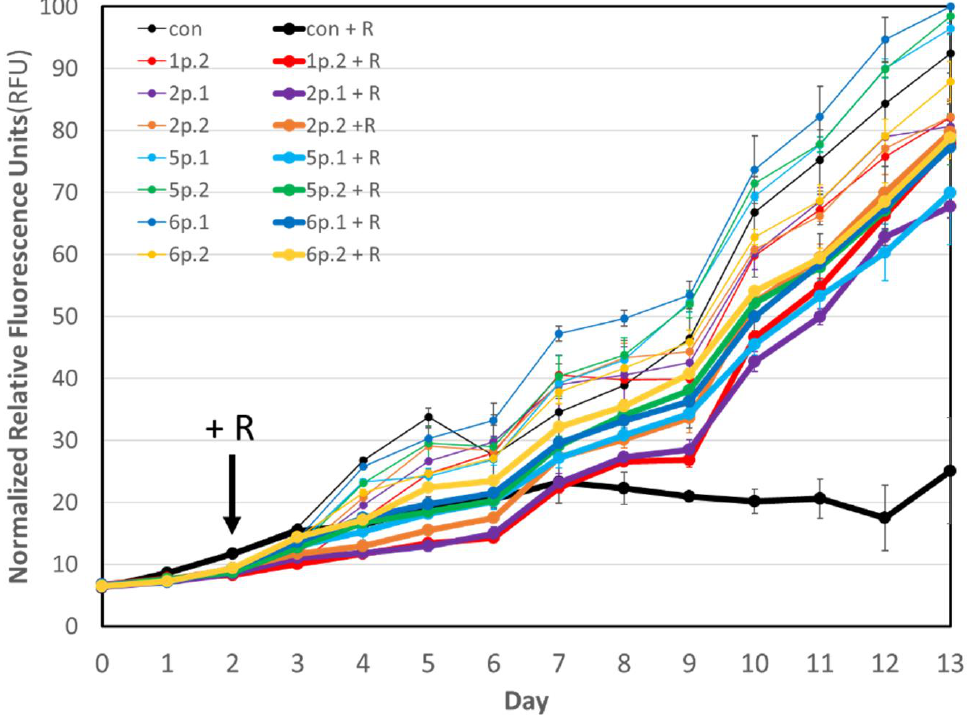
Figure 1. Daily chlorophyll fluorescence for M. salina cultures treated with bacterial communities (1p.2, 2p.1, 2p.2, 5p.1, 5p.2, 6p.1, 6p.2) in comparison to an untreated M. salina control (con) in the presence of rotifers (+R; thick lines) and absence (thin lines). Measurements were averaged for biological triplicates for each condition and error bars represent standard deviation ( n = 3). Rotifers were added on day 2. Data were normalized to the culture with the highest chlorophyll fluorescence (6p.1) over the cultivation